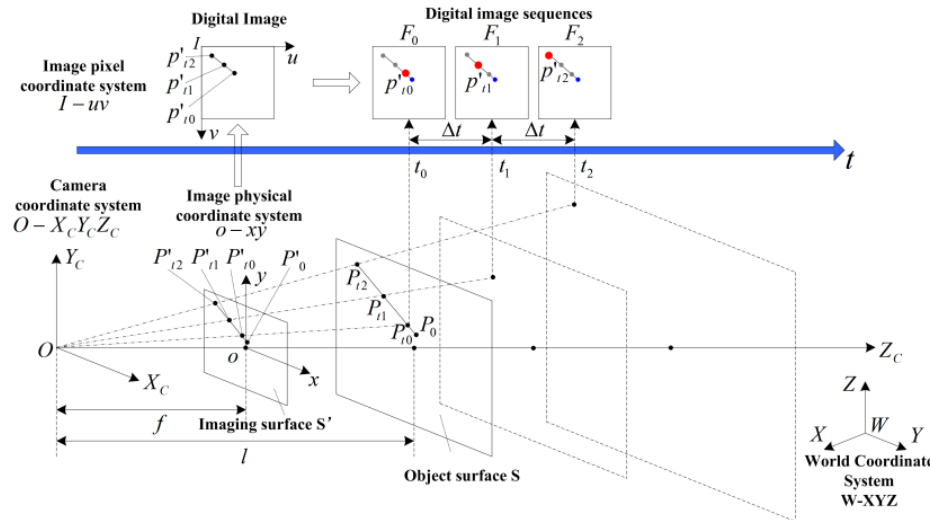
Figure 1. Schematic diagram of the joint time-space four-dimensional imaging model. In this model, the camera coordinate system and image coordinate system are estab- lished. The origin of the camera coordinate system is taken as the camera optical center O, the Z C -axis coincides with the camera optical axis, and the camera direction is taken as positive. The image coordinate system is established in the ortho-image plane S (cid:48) , which lies in the plane of the camera coordinate system, and f is the central perspective projection Z C = f focal length. The image physical coordinate system is established in the image plane S (cid:48) . The origin of the image physical coordinate system is the intersection o of the camera optical center O and the image plane S (cid:48) . The x-axis and y-axis of the image physical coordinate system are parallel to the X C -axis and Y C -axis of the camera coordinate system, respectively. The image pixel coordinate system I-uv is established, with the point I in the upper left corner of the image as the origin and the pixel as the coordinate unit. uv denotes the number of columns and rows of the pixel in the digital image, respectively,